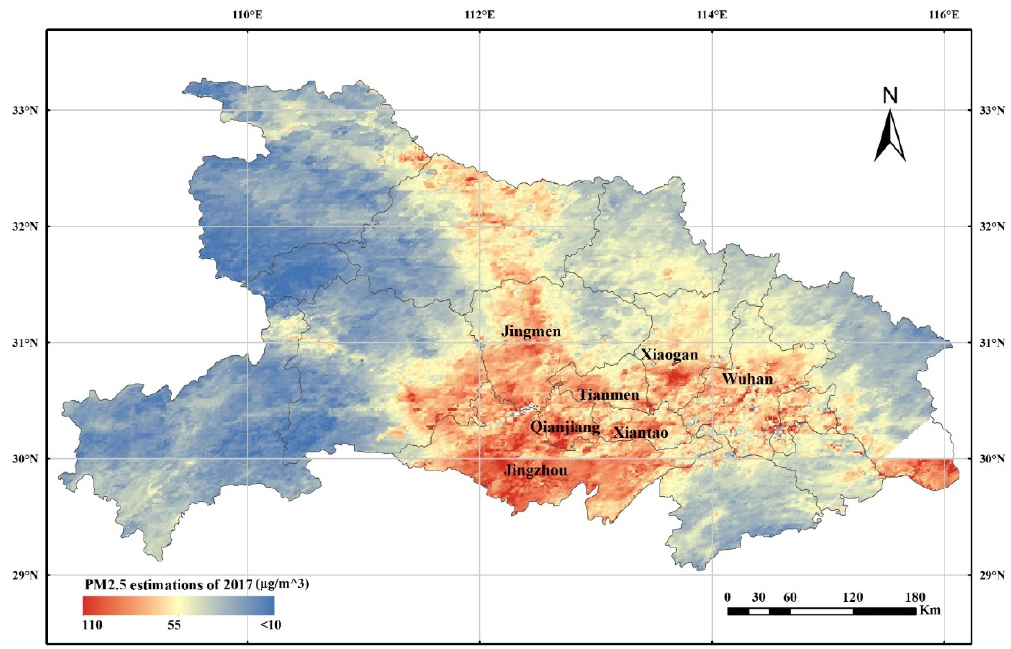
Figure 3. The estimated PM 2.5 average concentrations in the study area in 2017, with the selected optimal MSVR model at spatial resolutions of 1 km.